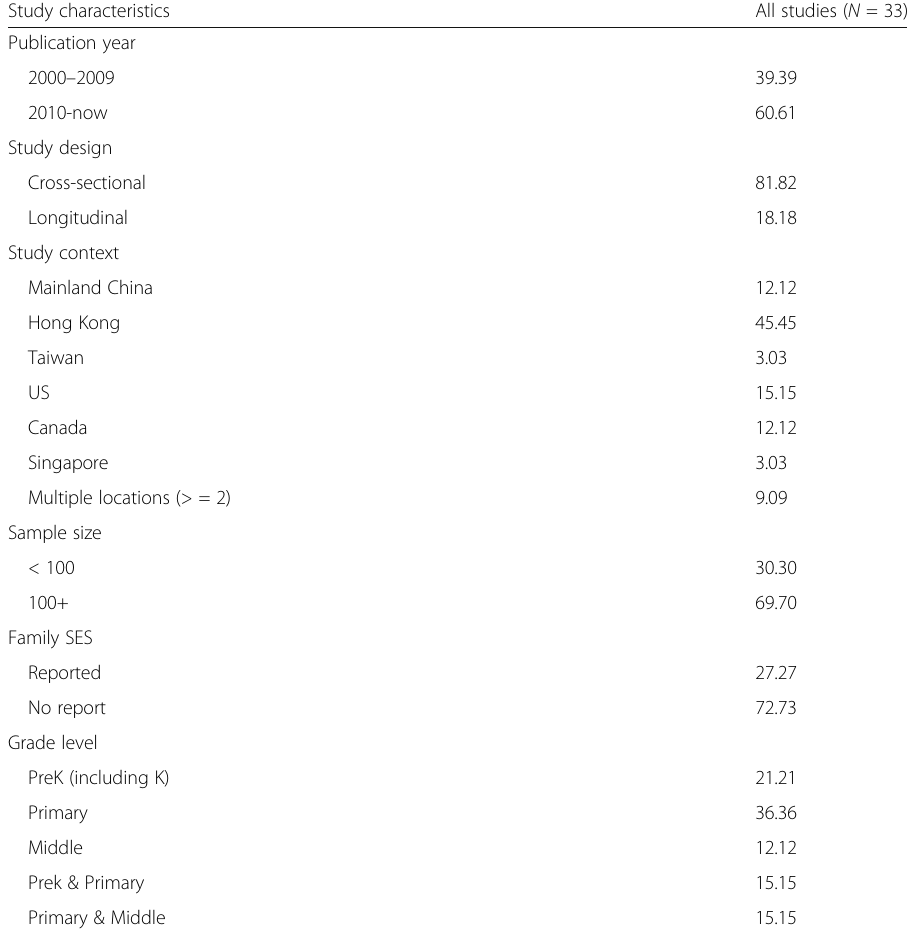
Table 1 Main characteristics of studies included for analysis Study